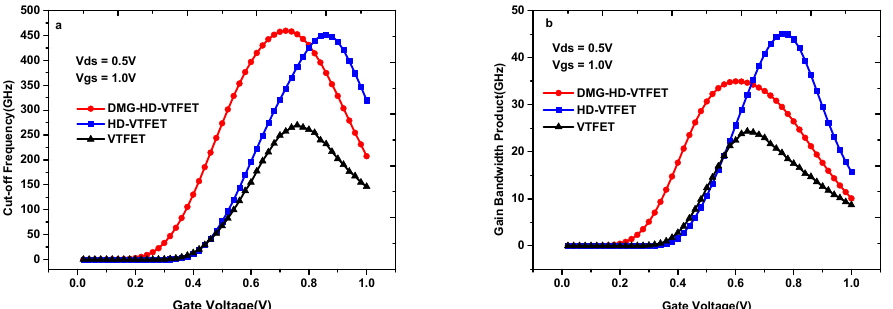
Figure 12. ( a ) The f T curves; and ( b ) the gain bandwidth (GBW) curves of VTFET, HD-VTFET, and DMG-HD-VTFET